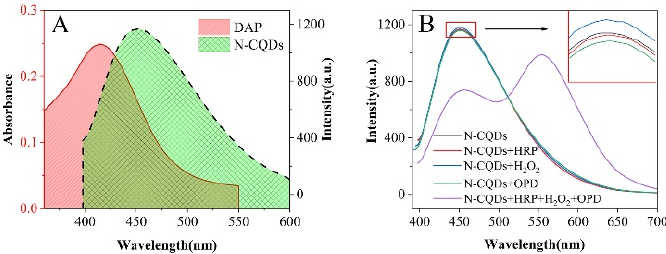
Figure 2. ( A ) UV–vis absorption spectrum of DAP and fluorescence of N ‐ CQDs (0.2 mg ∙ mL − 1 ). ( B ) Fluorescence spectrum of N ‐ CQDs (0.2 mg ∙ mL − 1 ) and after addition of HRP/H 2 O 2 /OPD/HRP + H 2 O 2 + OPD.